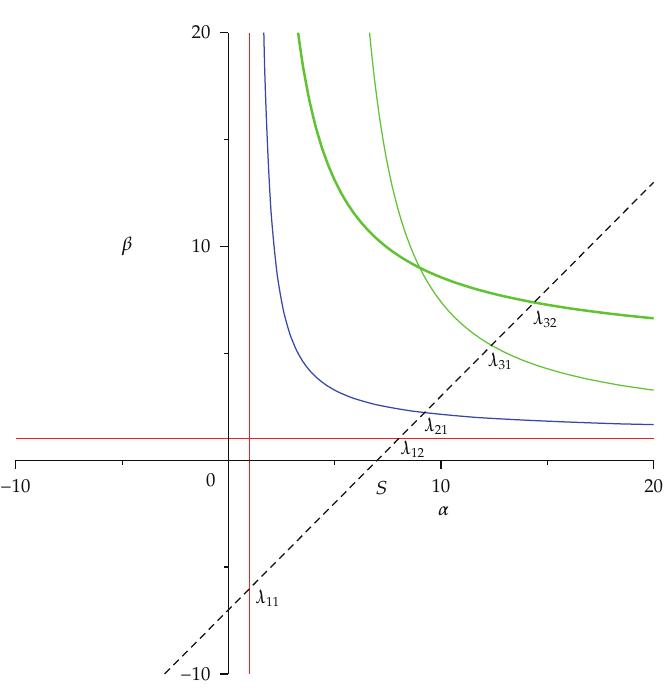
Figure 3: First few components in the Fuˇc´ ı k